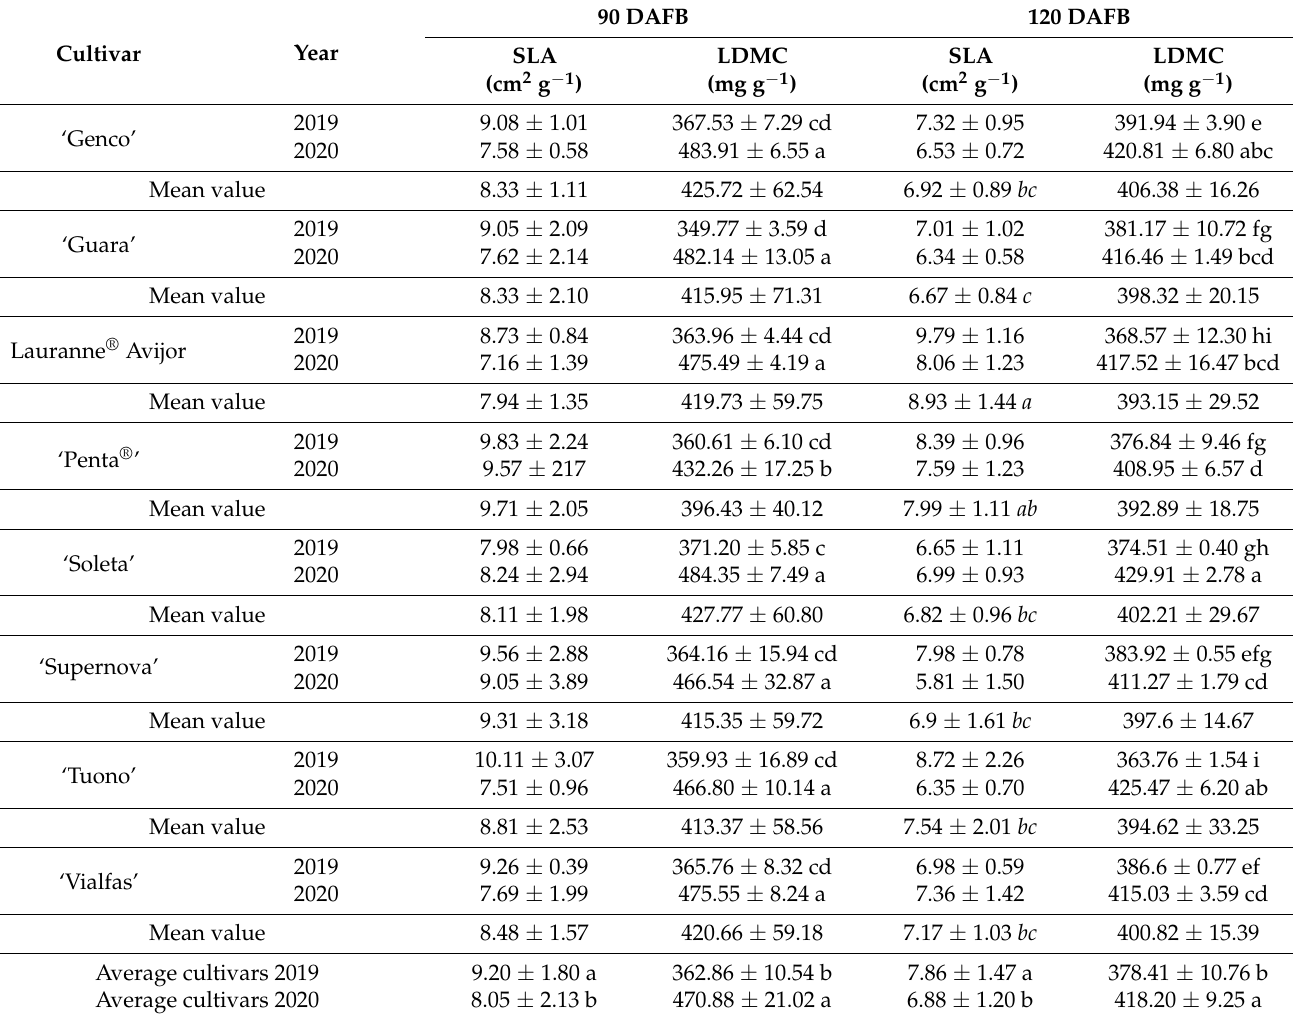
Table 2. Specific leaf area (SLA) and leaf dry matter content (LDMC) in almond plants at 90 and 120 DAFB over the years 2019–2020. Data are presented as mean ± standard deviation. Different lowercase letters on the columns indicate significant differences between means (Fisher’s test p < 0.05). Lowercase letters in italics describe the differences expressed as two-year mean values of the